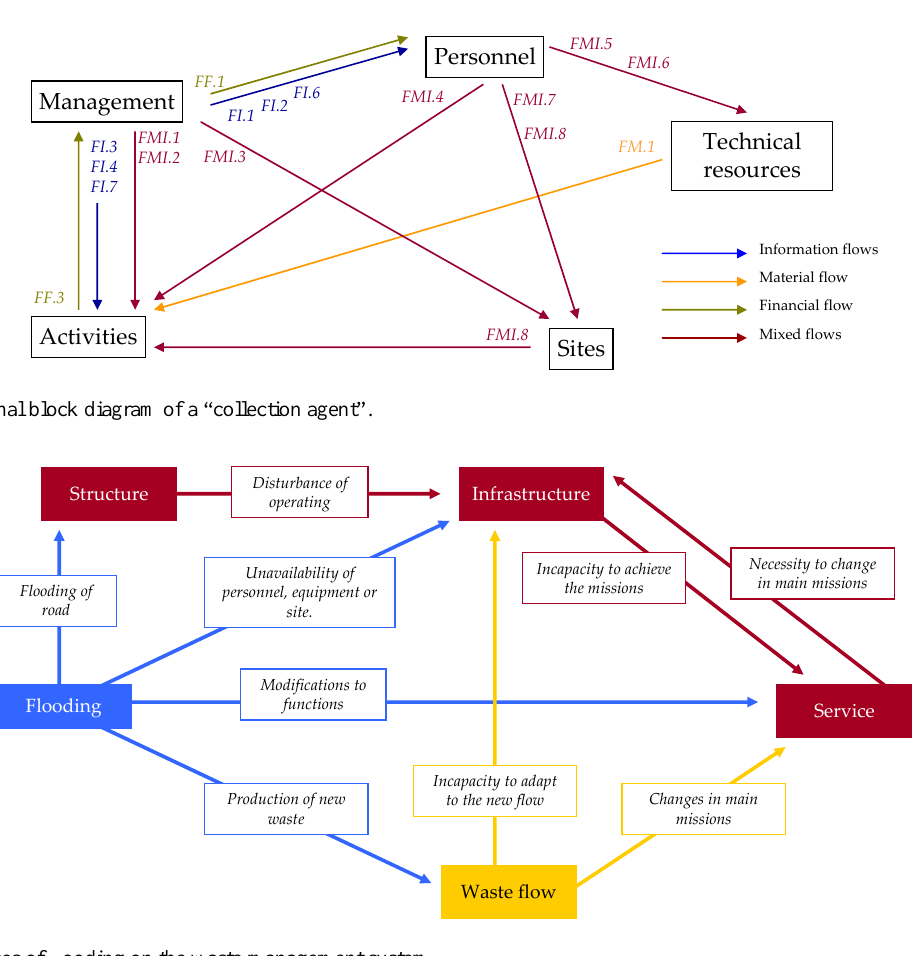
Fig. 8. Consequences of flooding on the waste management Figure 8 : Consequences of flooding on the waste management system 10